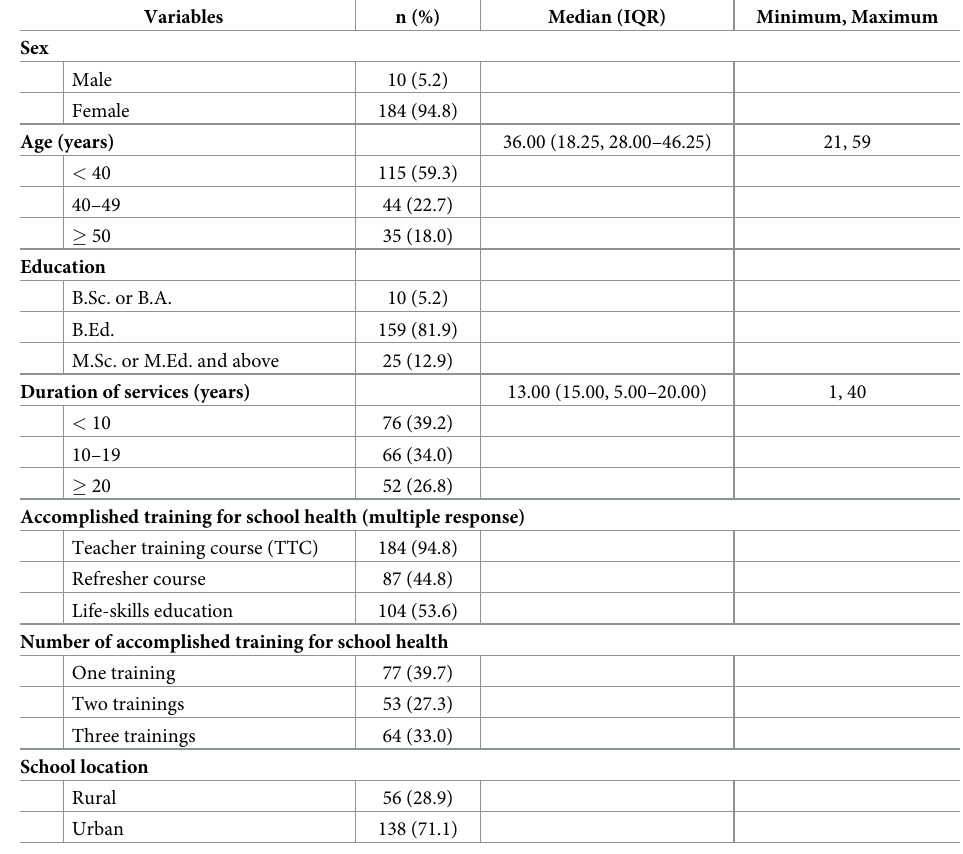
Table 1. Personal characteristics of high school